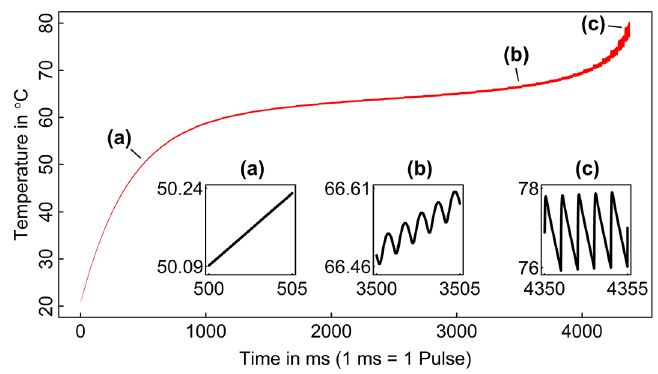
Figure 5. Temperature response of the micropillar. All 4383 pulses are presented. The main curve in red shows the variation of temperature in the micropillar with the upper and lower bounds corresponding maximum and minimum temperatures respectively. The sub plots show the temperature response at the centre of the micropillar, across a more sensitive time period where there is a development of localised heating as the dense temperature distribution of each pulse diffuses through the micropillar.